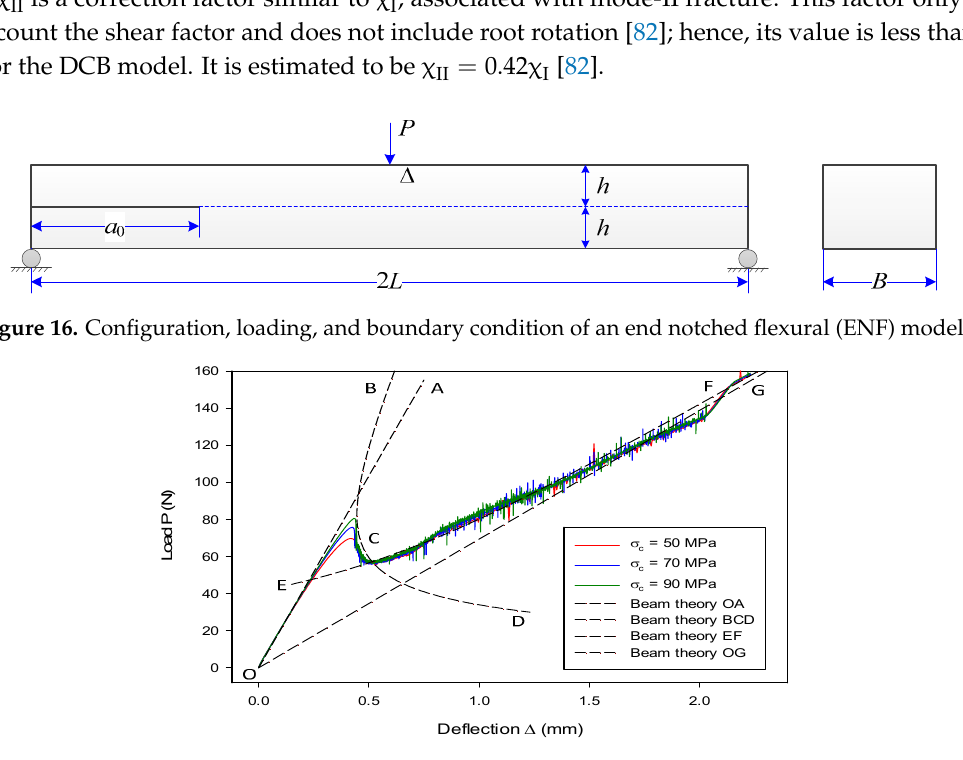
Figure 17. Load P as a function of deflection ∆ in the ENF model with different cohesive strengths.